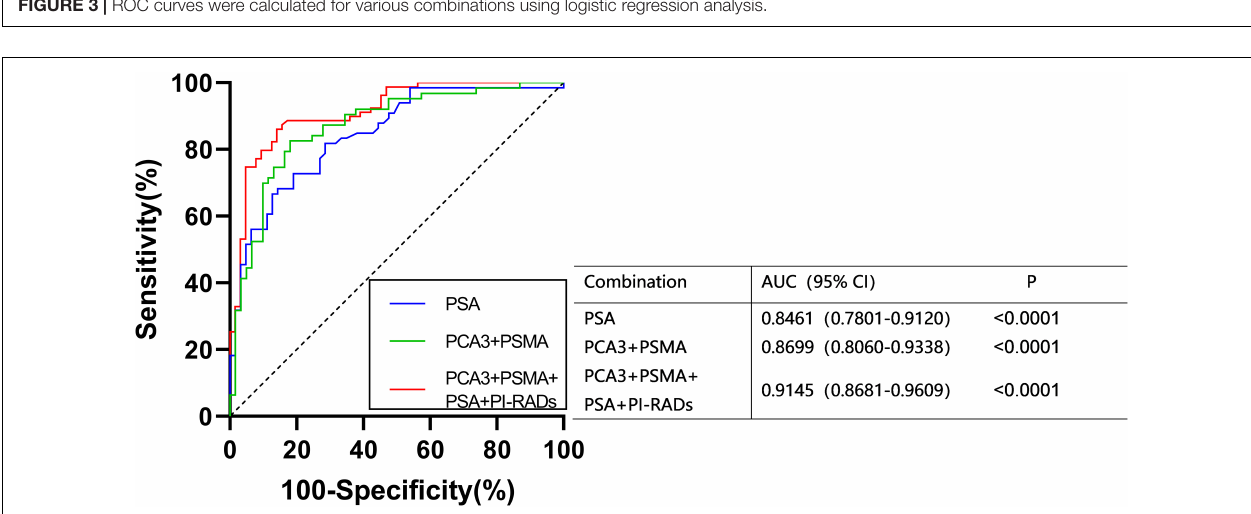
FIGURE 3 | ROC curves were calculated for various combinations using logistic regression analysis.